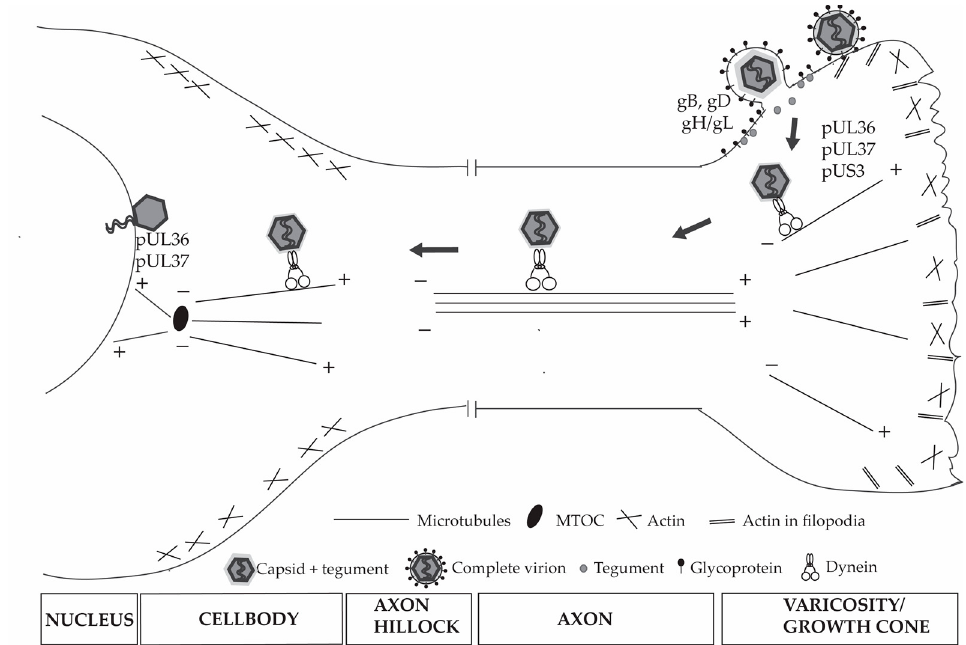
Figure 2. Entry of HSV-1 into neurons. HSV-1 enters neuronal cells by attachment and fusion of the viral envelope with the plasma membrane and this process is mediated by viral glycoproteins gB, gD, and gH/gL. During membrane fusion, the HSV-1 envelope and its glycoproteins remain associated with the plasma membrane while most tegument proteins dissociate from the incoming capsid. The capsid with associated inner tegument pUL36, pUL37, and pUS3 traverses the actin cortex and is transported along microtubules towards the MTOC to the nucleus in the cell body. The retrograde transport of incoming capsids to the nucleus is mediated by the cellular motor dynein and requires pUL36 and pUL37. MTOC, microtubule organizing center.